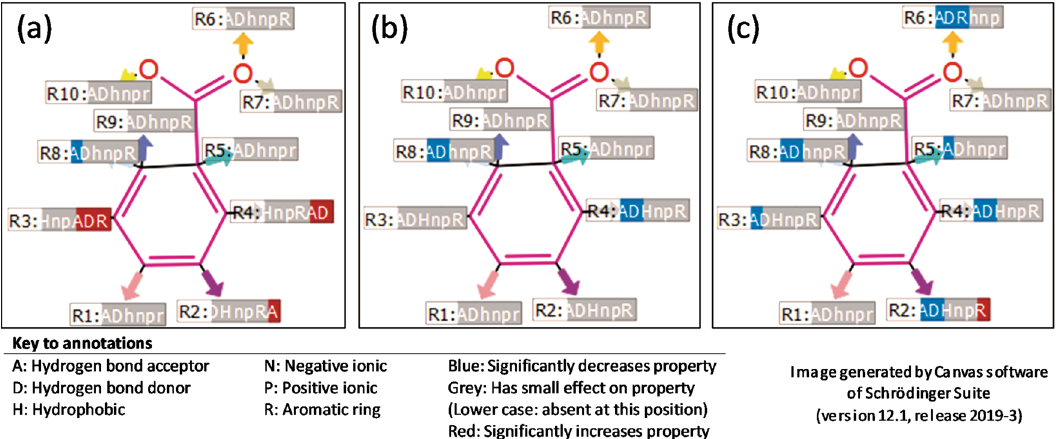
Figure 6. Pharma rational quantitative structure–activity relationship models indicating the R-groups most likely responsible for the ( a ) tyrosinase activity, ( b ) tyrosinase structure (PBD: 2Y9X) docking score properties and ( c ) tyrosinase related protein 1 structure (PBD: 5M8P) docking score properties. According to the six pharmacophore elements analysed, the substituent groups at the R2 position (hydrogen bond acceptor), R3 (hydrogen bond acceptor, hydrogen bond donor and aromatic ring) and R4 (hydrogen bond acceptor and hydrogen bond donor) had a significant increase on the tyrosinase activity. The substituent groups at the R8 position (hydrogen bond acceptor) had a significant decreasing effect on the activity. The substituent groups at the R4 position (hydrogen bond acceptor and hydrogen bond donor) and R8 position (hydrogen bond acceptor and hydrogen bond donor) had a significant decreasing effect on the tyrosinase structure docking score properties. The substituent groups at the R2 position (hydrogen bond acceptor and hydrogen bond donors), R3 (hydrogen bond acceptor), R4 (hydrogen bond acceptor and hydrogen bond donors), R5 (hydrogen bond acceptor), R6 (hydrogen bond acceptor, hydrogen bond donors and aromatic ring), and R8 (hydrogen bond acceptor and hydrogen bond donor) had a significant decreasing effect on the tyrosinase-related protein 1 structure docking score properties. In contrast, the substituent groups at R2 (aromatic ring) had a significant increasing effect (https:// www. schro dinger. com/ canvas; version 4.1.013, release